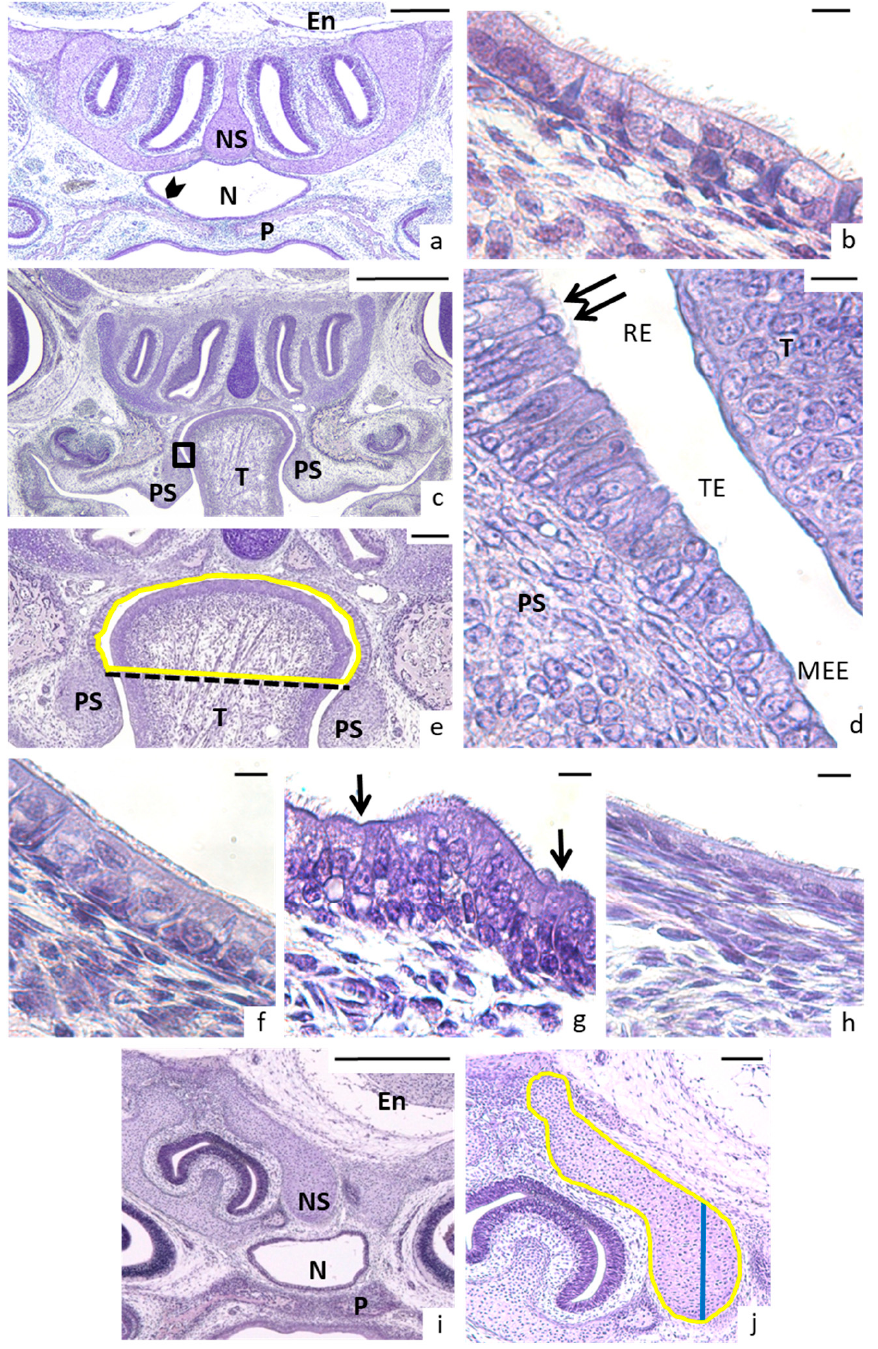
Figure 4. Nasopalatin region. ( a ) Coronal section of a control fetus: the nasopharyngeal duct (N) was placed between palate (P).and the nasal septum (NS), which was below the encephalon (En). Arrowhead marked the area of interest. ( b ) Magnification the control respiratory epithelium with the columnar and ciliated cells. ( c ) Malformed fetus with the tongue (T) placed between palatal shelves (PS). ( d ) Magnification of the rectangle showing the transition epithelium (TE) among respiratory (RE) to medial edge epithelium (MEE). Arrows: cilia. ( e ) Measurement of nasopharynx area (yellow line) in cleft palate. The lower limit was an imaginary line (discontinuous black line) drawn on the transitional epithelium in clef palate fetuses. ( f ) Anomalous nasopharyngeal cilia. ( g ) Arrows pointed lack of cilia in some cells. ( h ) The cells were not columnar, and cilia seemed to be atrophied. ( i ) Aberrant shape of the nasal septum (NS) and nasopharyngeal duct (N). The palate (P) was normal. En: Encephalon. ( j ) Magnification of altered nasal septum showing how the area was measured (yellow line) the height of the septum (blue line). Scale bars: ( a , c , i ) 500 µ m; ( b , d , f – h ) 10 µ m; ( e , j ) 100 µ m.